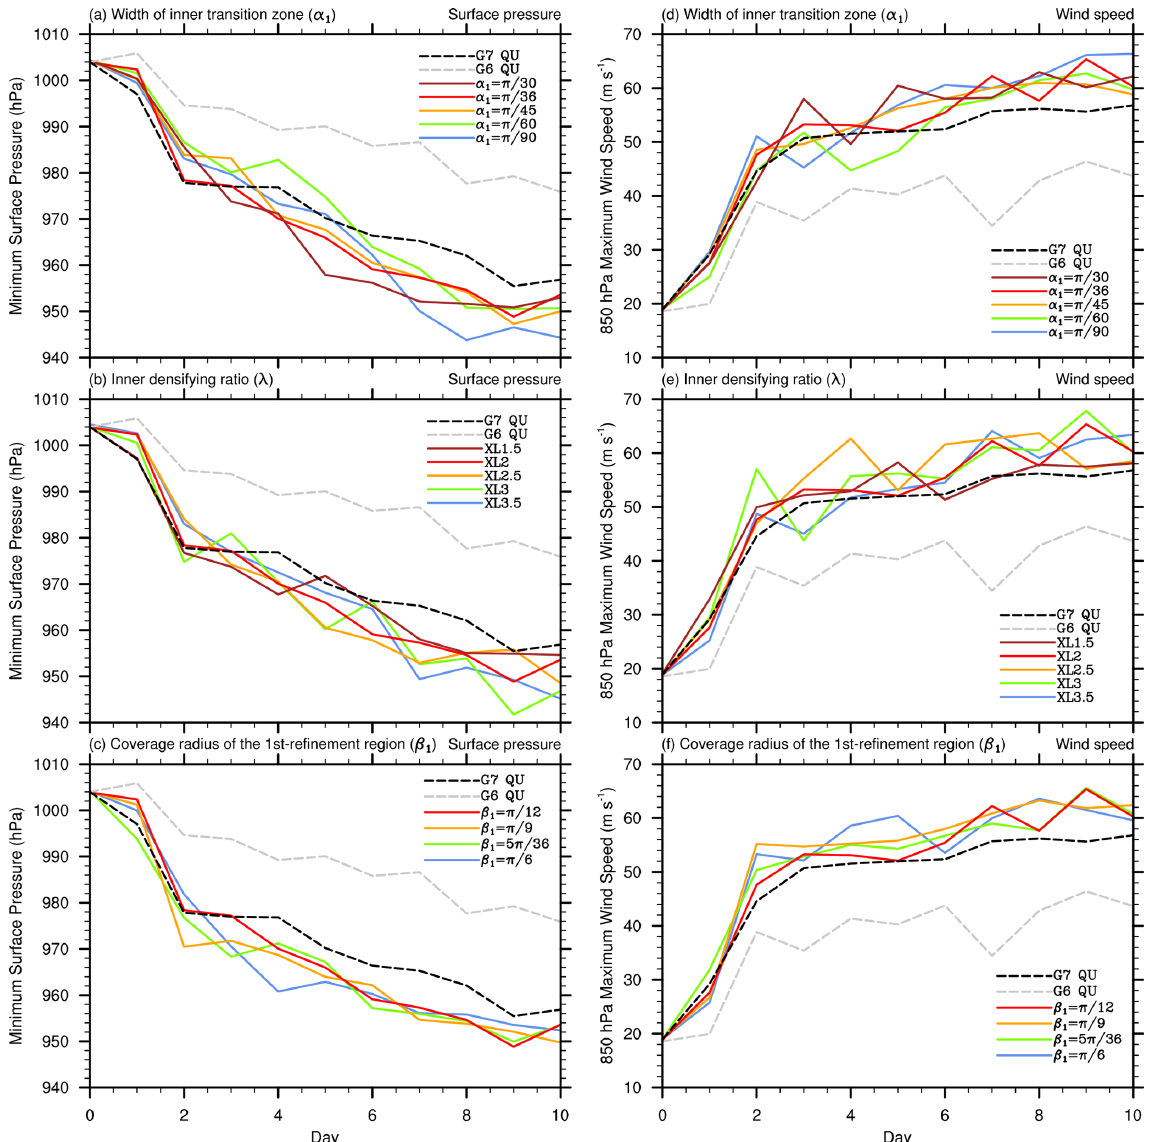
Figure 11. Idealized tropical cyclone test. Temporal evolution of minimum surface pressure and maximum horizontal wind speed at 850hPa based on the quasi-uniform G6 and G7 meshes and the hierarchical refinement meshes by varying (a, d) α 1 , (b, e) λ , and (c, f) β 1 . When one parameter is altered, the other two parameters are fixed, as in the control run ( α 1 = π/ 36, λ = ( 1 / 2 ) 4 , and β 1 = π/ 12 ) . The three mesh parameters control the width of the inner transition zone, the inner densification ratio, and the coverage radius of the first-refinement